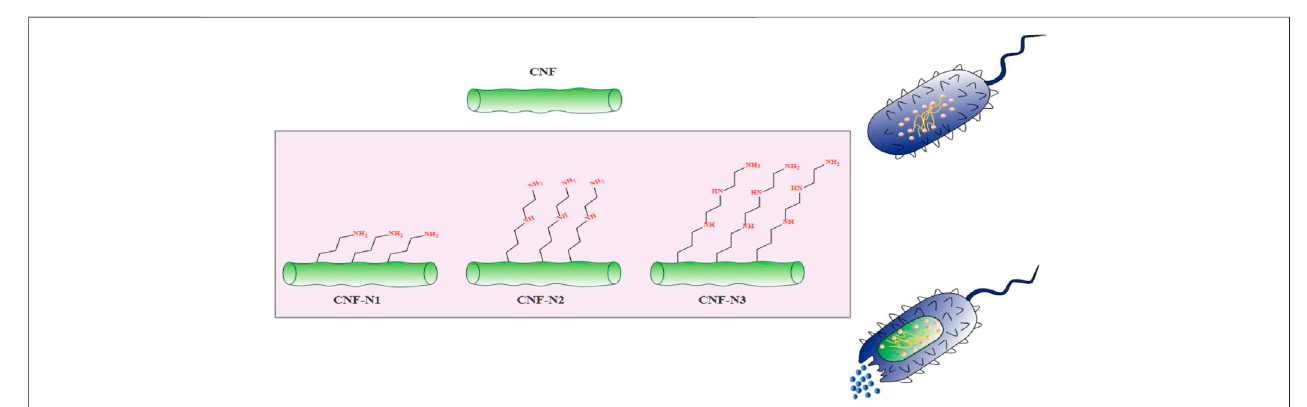
FIGURE 3 | The antibacterial activity of aminoalkyl grafted CNF. This fi gure adapted from Saini et al. (Saini, Belgacem et al., 2017).